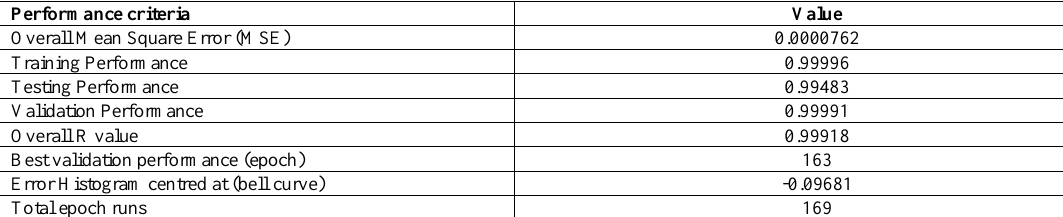
Table 4. Final results of optimised MLP.